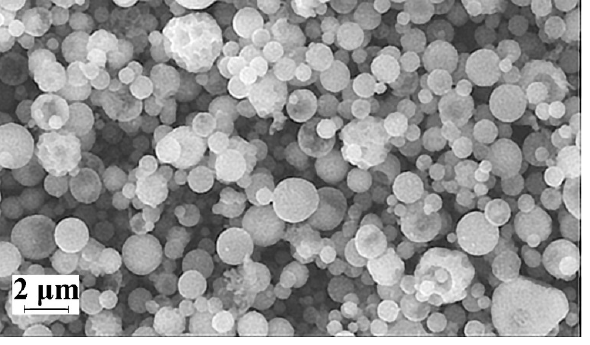
Figure 5. Scanning electron microscopic observations of aerosol powders, made of working solution with additive of urea portion.